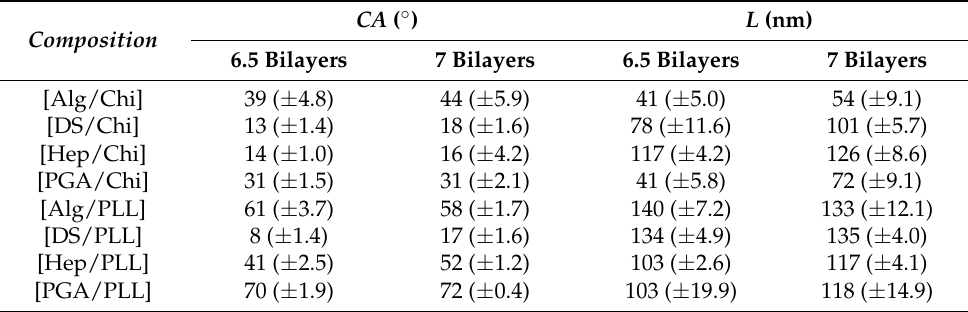
Table 1. Static contact angle ( CA ), thickness ( L ), and measurements of 6.5 and 7 bilayers of each BioPEM component a.